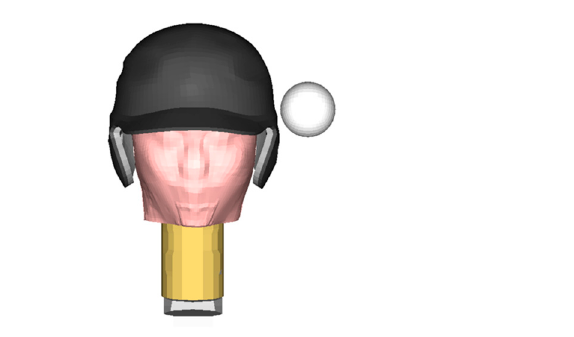
Figure 4. Initial condition of the baseball impact simulation using FE models of the human head, the helmet and the ball.